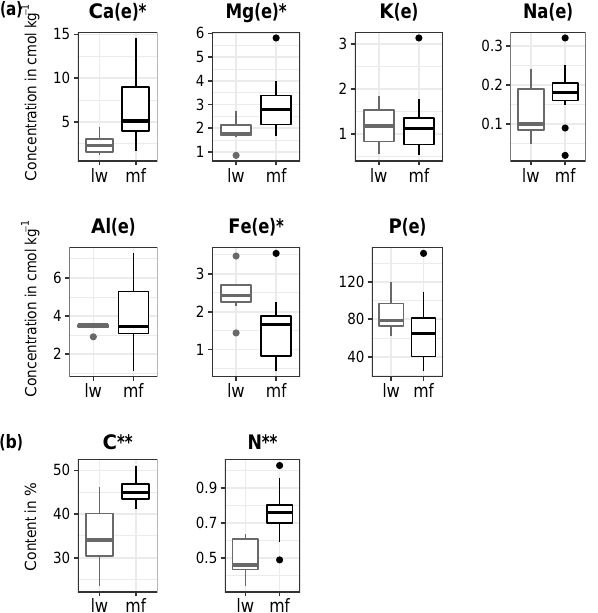
Figure 3. Distributions of chemical compounds in the FH hori- zon in lichen woodland and moss forest plots (lw and mf, respec- tively). (a) Concentrations of exchangeable base cations and ex- tractable P, (b) organic C and N. Boxplots represent the distribu- tion around the median values. “(e)” indicates exchangeable or ex- tractable elements. Asterisks indicate a significant difference using mixed models (see Materials and methods), with ∗ p value<0.05, ∗∗ p value<0.01 and ∗∗∗ p